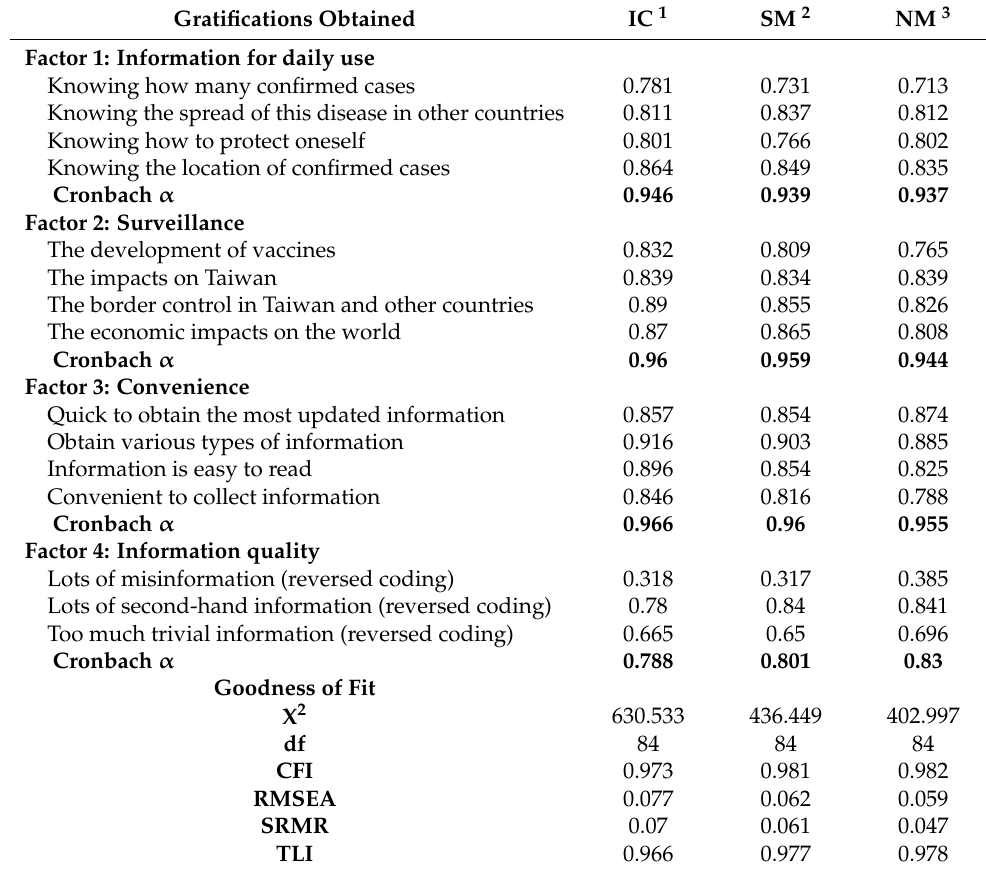
Table 1. Confirmatory factor analysis for three media. Gratifications